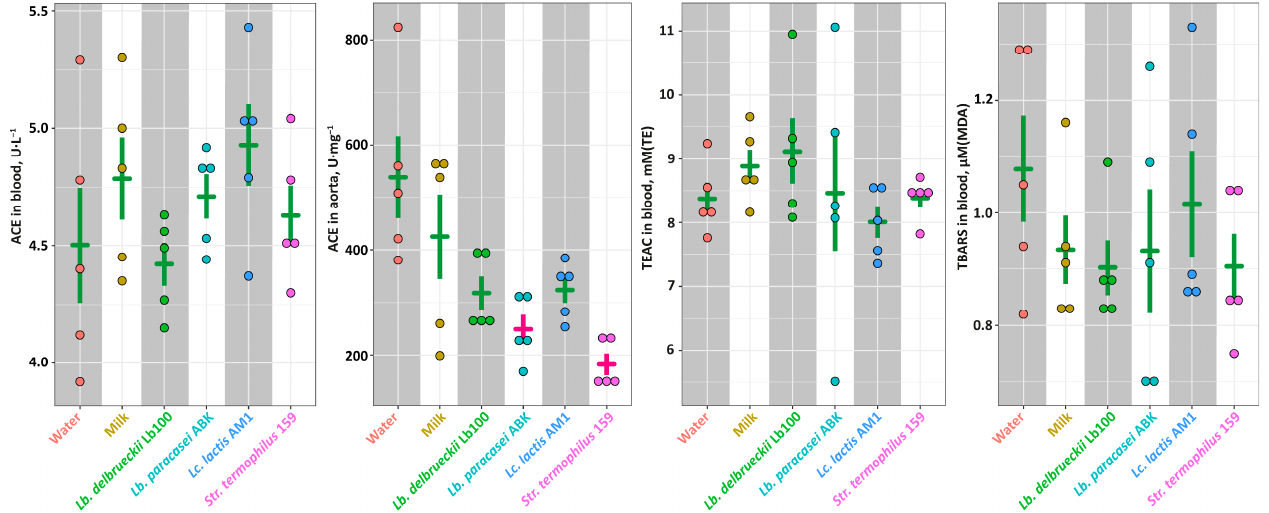
Figure 3. The ACE activity in blood and aorta, as well as the markers of the oxidant-antioxidant status for studied animal groups. The bars (Mean ± SE) for the groups between which no statistically-significant differences were detected are depicted in the same color.